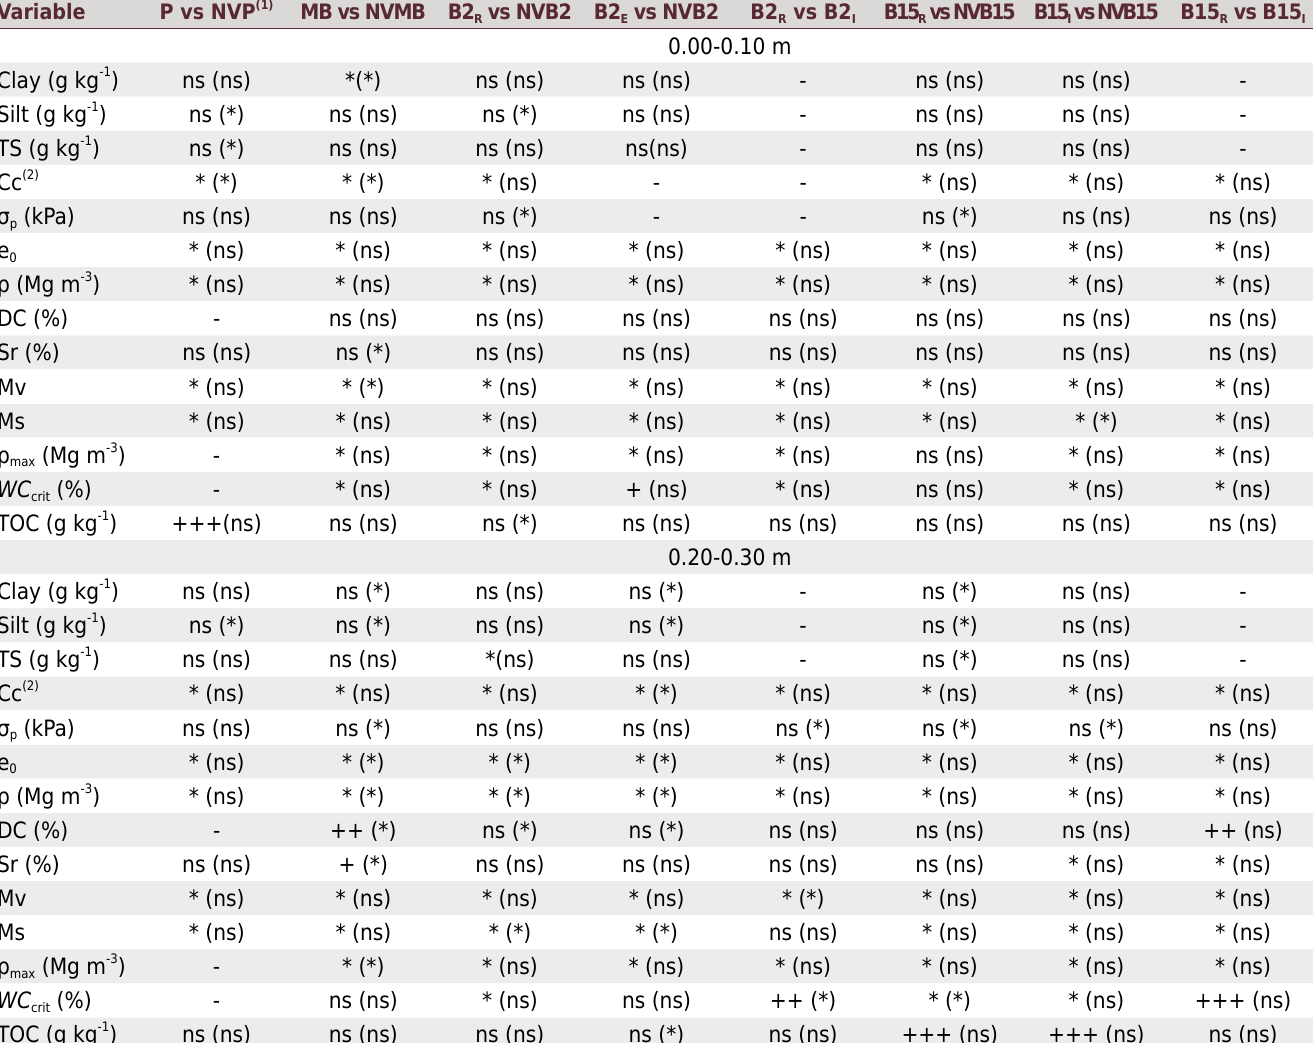
Table 3. Results of the t-test and F-test for the physical and chemical properties of the soil at layers of 0.00-0.10 and 0.20-0.30 m in areas under irrigated cultivation and natural vegetation (NV) in the Jaguaribe Irrigated Area, Apodi, CE, Brazil Variable P vs NVP